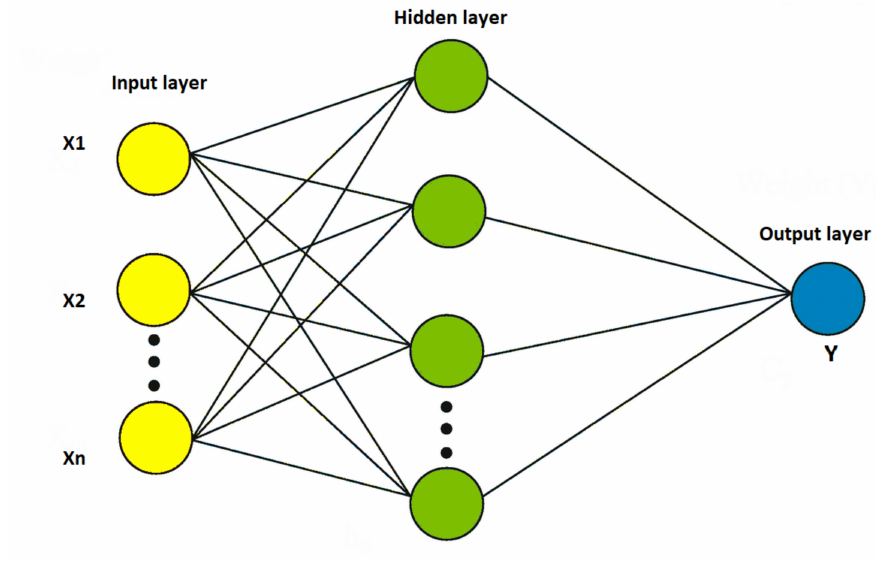
Figure 1. A typical ANN architecture (by the